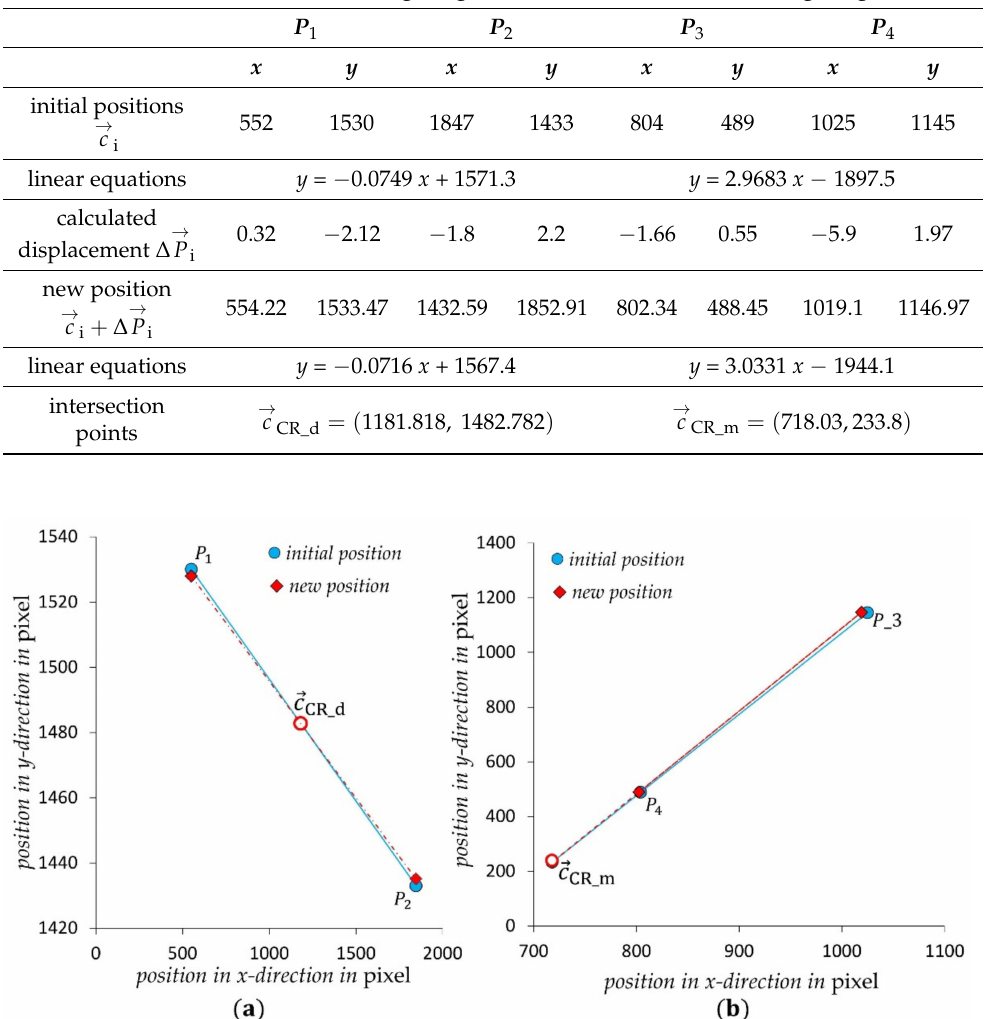
Figure 9. Positions of points P 1 − 4 before and after the torsional load and positions of the centers of rotation ( a ) for the direct image segment and ( b ) for the mirrored image